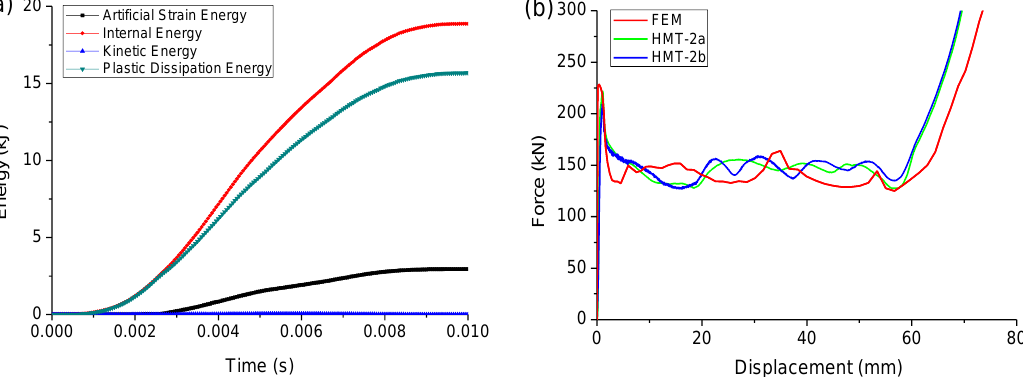
Figure 12. ( a ) Energy variation of HMT-2 in computation to clarify the quasi-static loading condition and ( b ) FEM force – displacements curves compared with the experiment to validate the feasibility of the FEM.